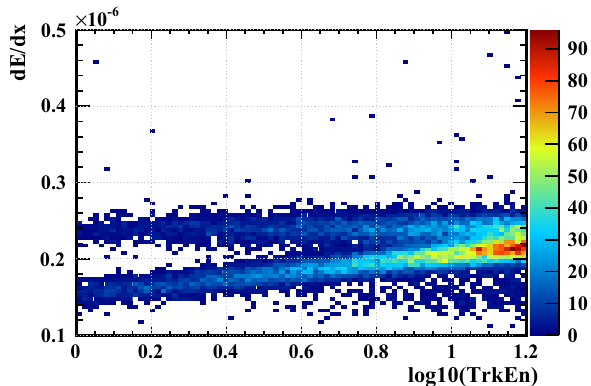
Fig. 2 Fractal dimension using both ECAL and HCAL for e − , μ − and π + at 40 GeV FD_ECALF10FD_ECALL20NH_ECALF10dEdx EcalNHitHcalNHitNLEcalNLHcalmaxDisHtoLavDisHtoLEcalEngraDepthcluDepthminDepthMaxDisHelFD_allFD_ECALFD_HCALEEClu_L10EEClu_REEClu_rrms_Hcalav_NHHAL_Ecal